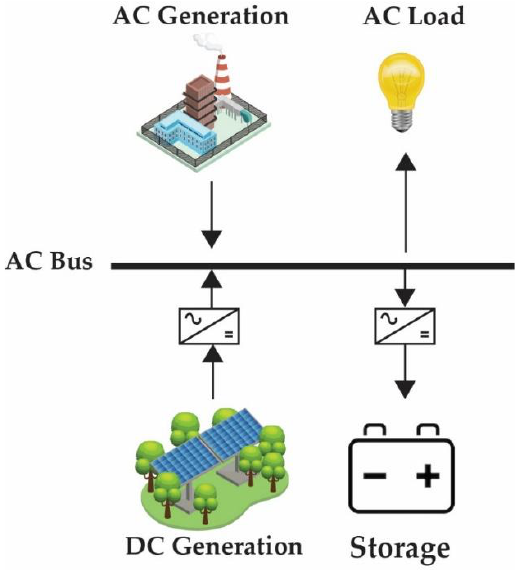
Figure 6. AC bus architecture of campus microgrids.